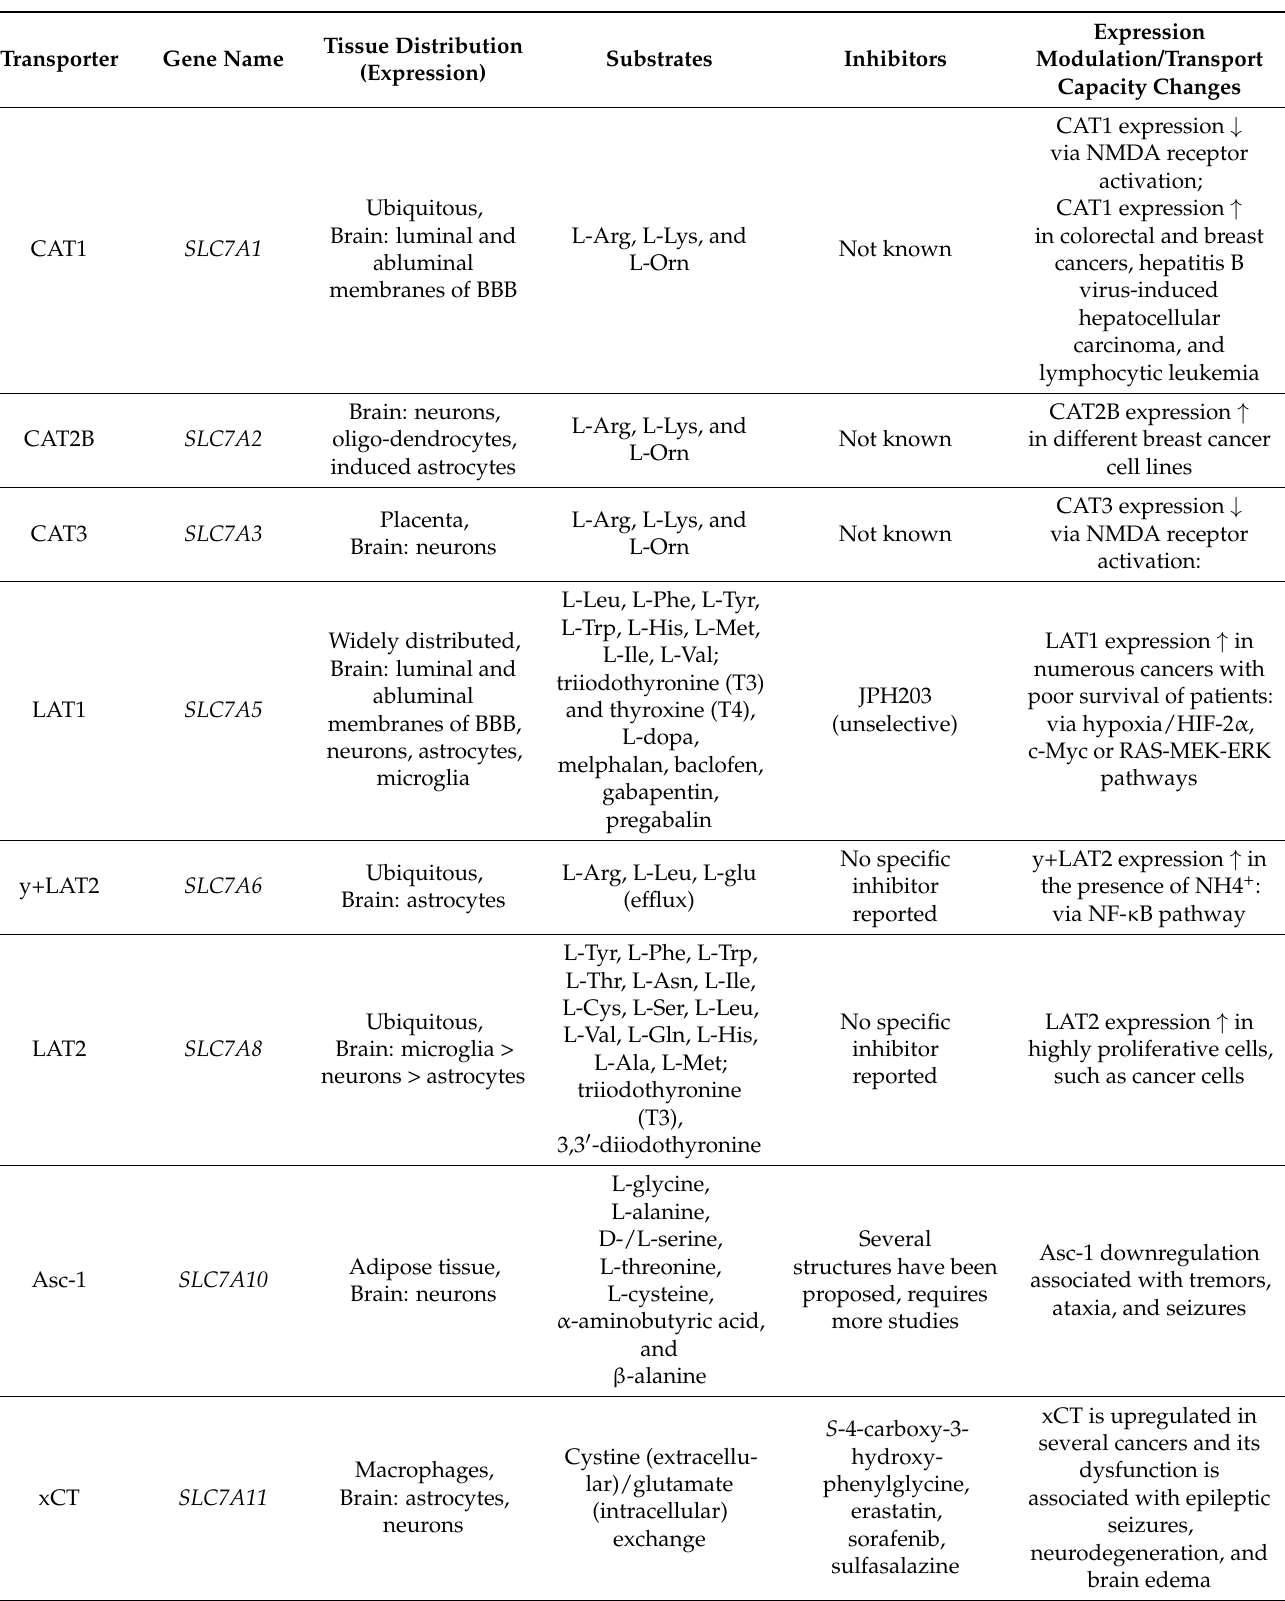
Table 3. Tissue distribution, substrates, inhibitors, and expression/function modulators of CAT1–3 and LAT1–2, y+LAT2, Asc-1, and